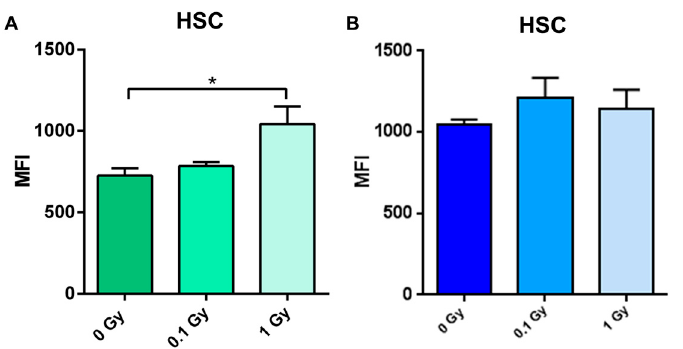
Figure 4. Comparative analysis of the levels of reactive oxygen species in response to low-dose radiation. Mean fluorescence intensity (MFI) for 2’,7’ –dichlorofluorescin diacetate (DCF-DA) in HSCs of C57BL/6J ( A ) and CBA/J ( B ) mice. Asterisks (*) denote significant ( p < 0.05) difference from control ( n = 5/group).